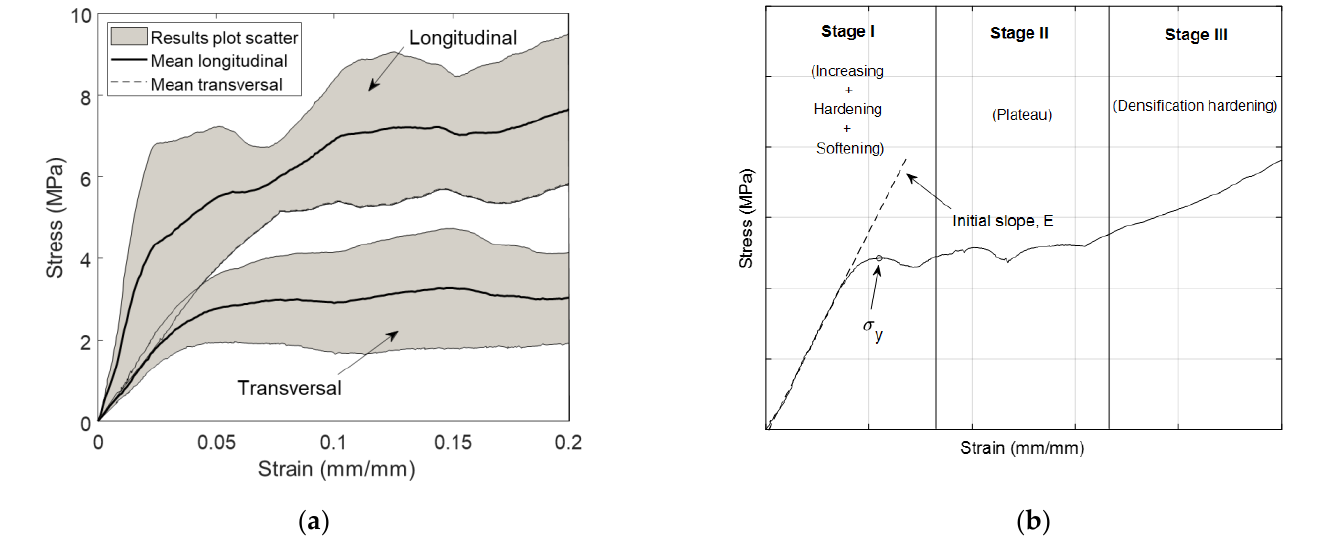
Figure 7. Uniaxial compression tests curve in both loading directions ( a ); example curve of the behavior of trabecular bone under uniaxial compression conditions ( b ).